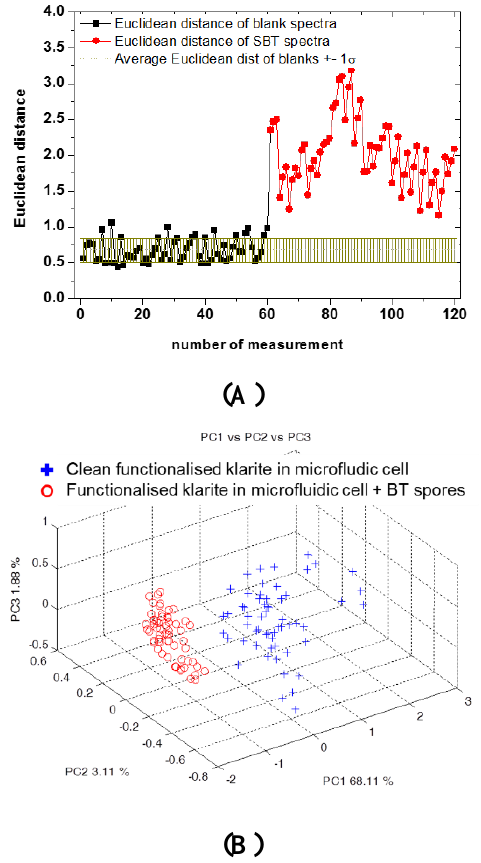
Figure 5. ( A ) Euclidean distance for the blank spectra (black dots) and SBT spectra (red dots) compared to the average value of the Euclidian distance obtained for the blank spectra (the brown line shows the range individuated by mean value ± 1 s B ). ( B ) First three principal component (PC) score plots of the SERS spectra acquired on the clean cartridge (blue crosses) and inoculated with SBT (red dots).